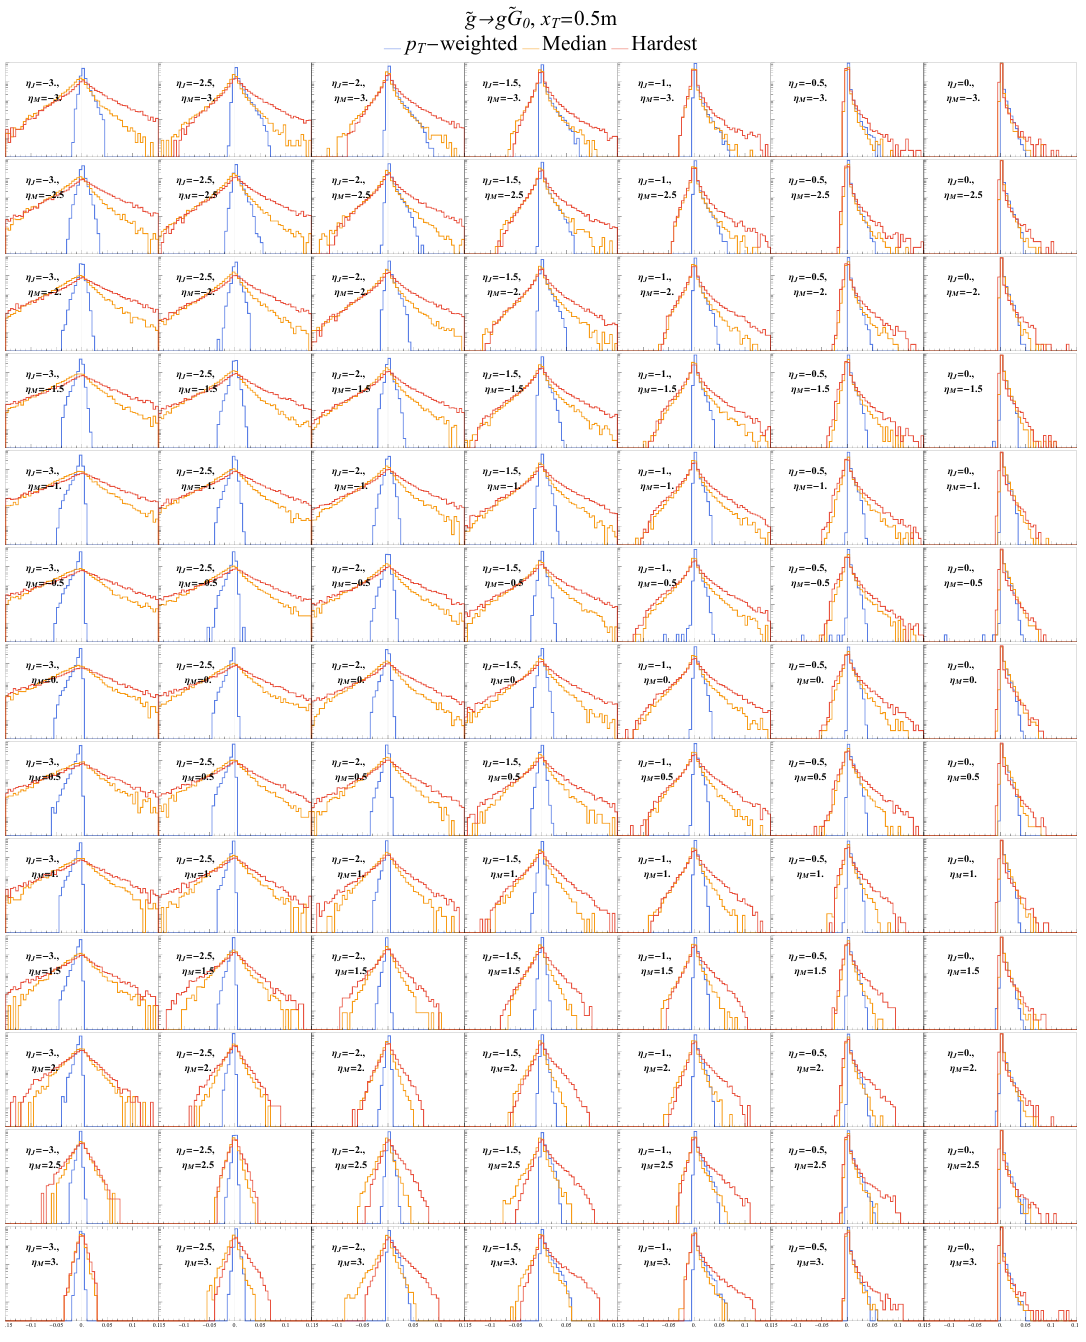
Figure 20 . The relative time difference distribution for the p T -weighted (blue), median (yellow), and hardest (red) times as a function of η ( x -axis) and of η ( y -axis) with a transverse decay J M location of x = 0 . 5 m . The vertical axis in each plot is in log-scale and ranges from 10 − 5 to 1 T,M